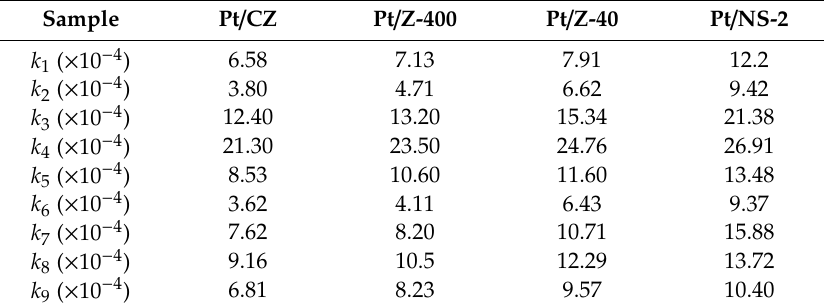
Table 5. Calculated rate constants for the HDO of guaiacol.